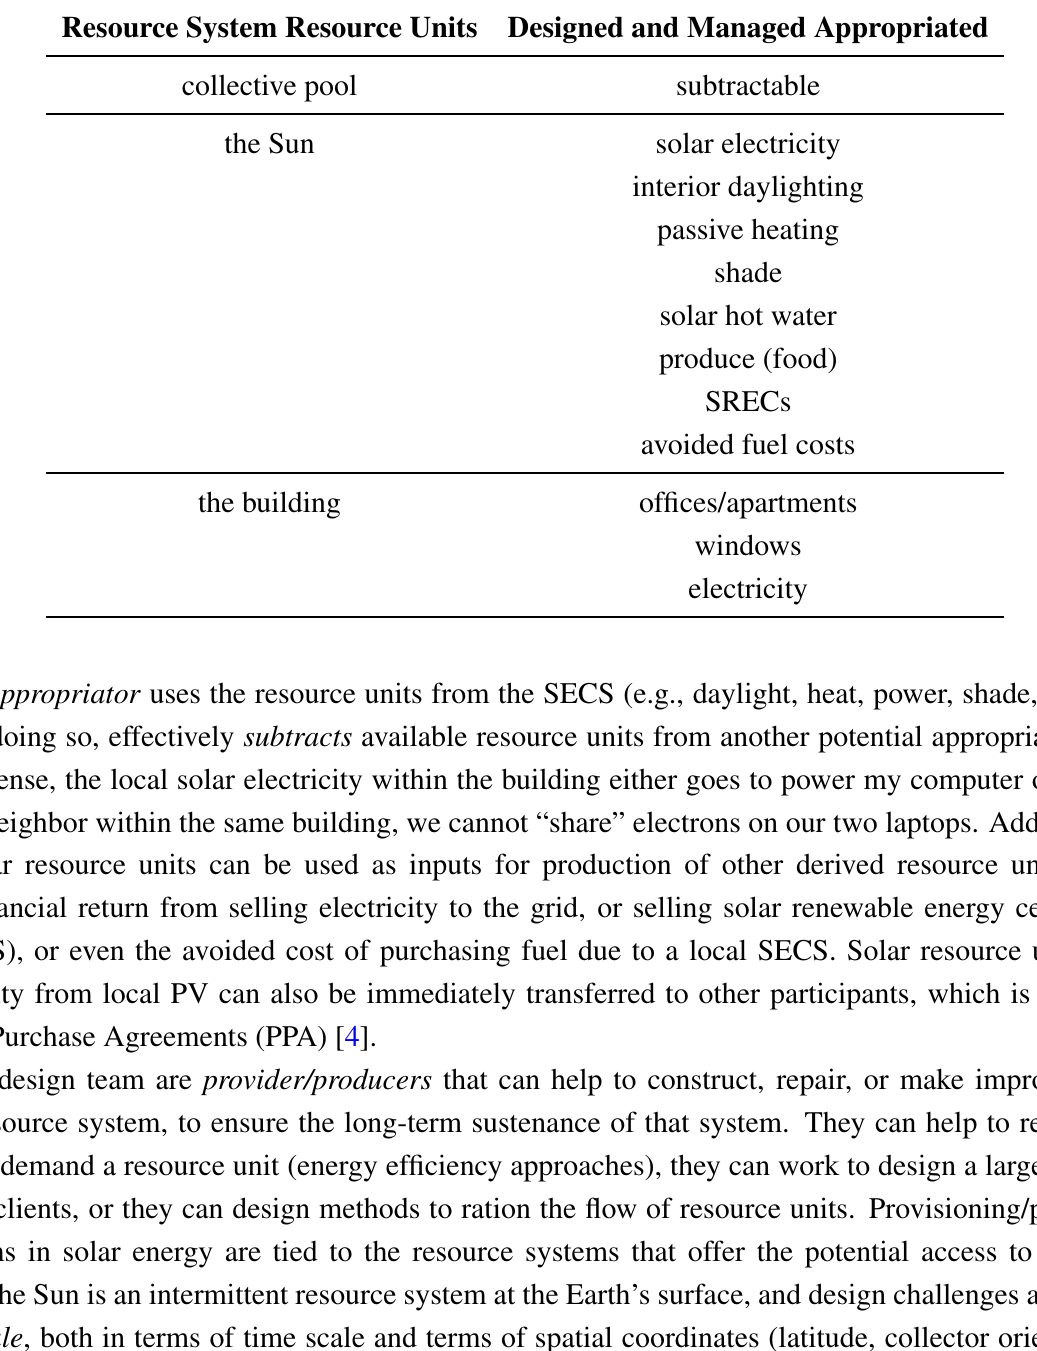
Table 3. Resource systems and resource units in